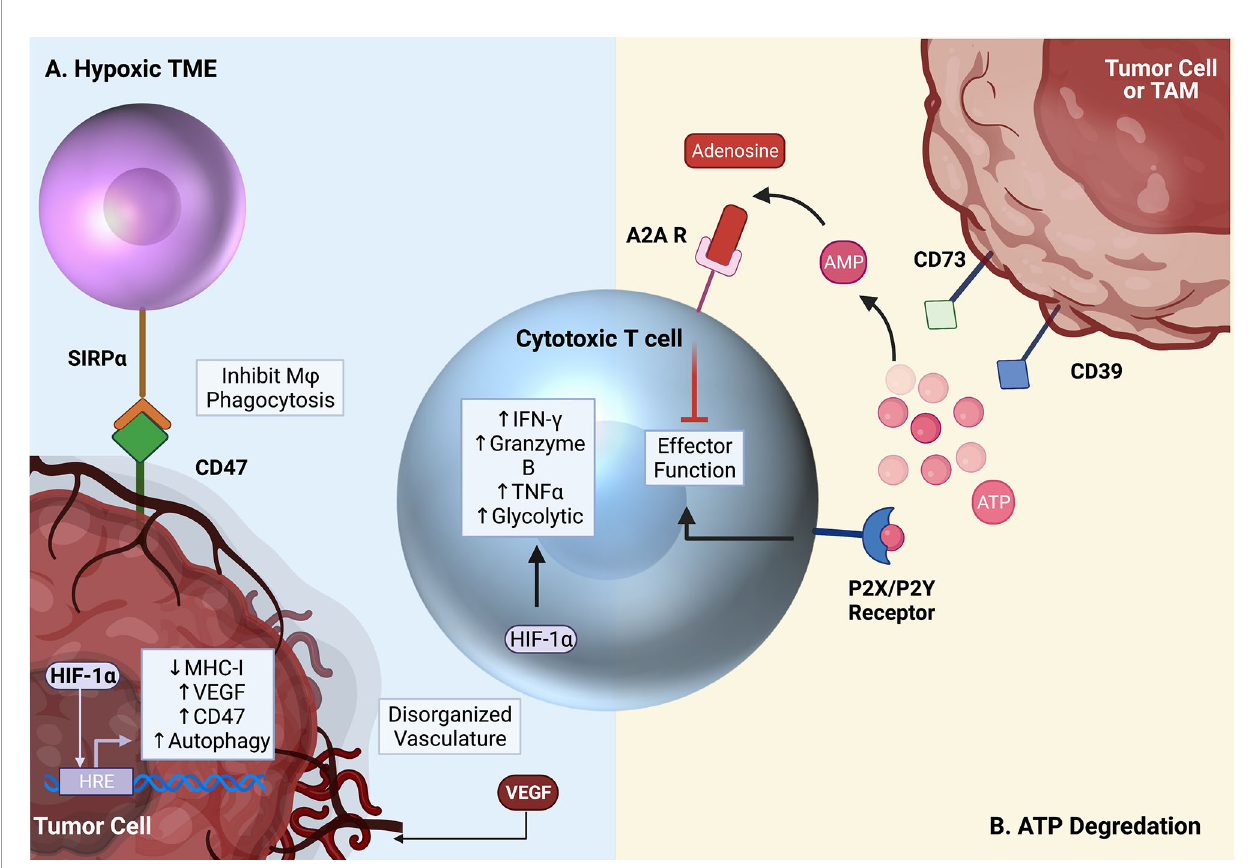
FIGURE 4 | Critical pathways targeted by emerging therapies. (A) The TME is characterized by hypoxia and low glucose. Increased VEGF expression by tumor cells and local immune cells leads to the creation of disorganized vasculature, ultimately worsening the metabolic environment. HIF-1 a leads to the activation of several pro-tumor pathways, but also contributes to supporting T cell effector function in the hypoxic TME. (B) Free ATP in the TME activates T cells through the P2X/P2Y receptors. In the TME, however, free ATP is converted to immunosuppressive adenosine by surface CD39 and CD73 expression on tumor cells and TAMs. Adenosine then binds to the A2A receptor on T cells, inhibiting effector function. Created with